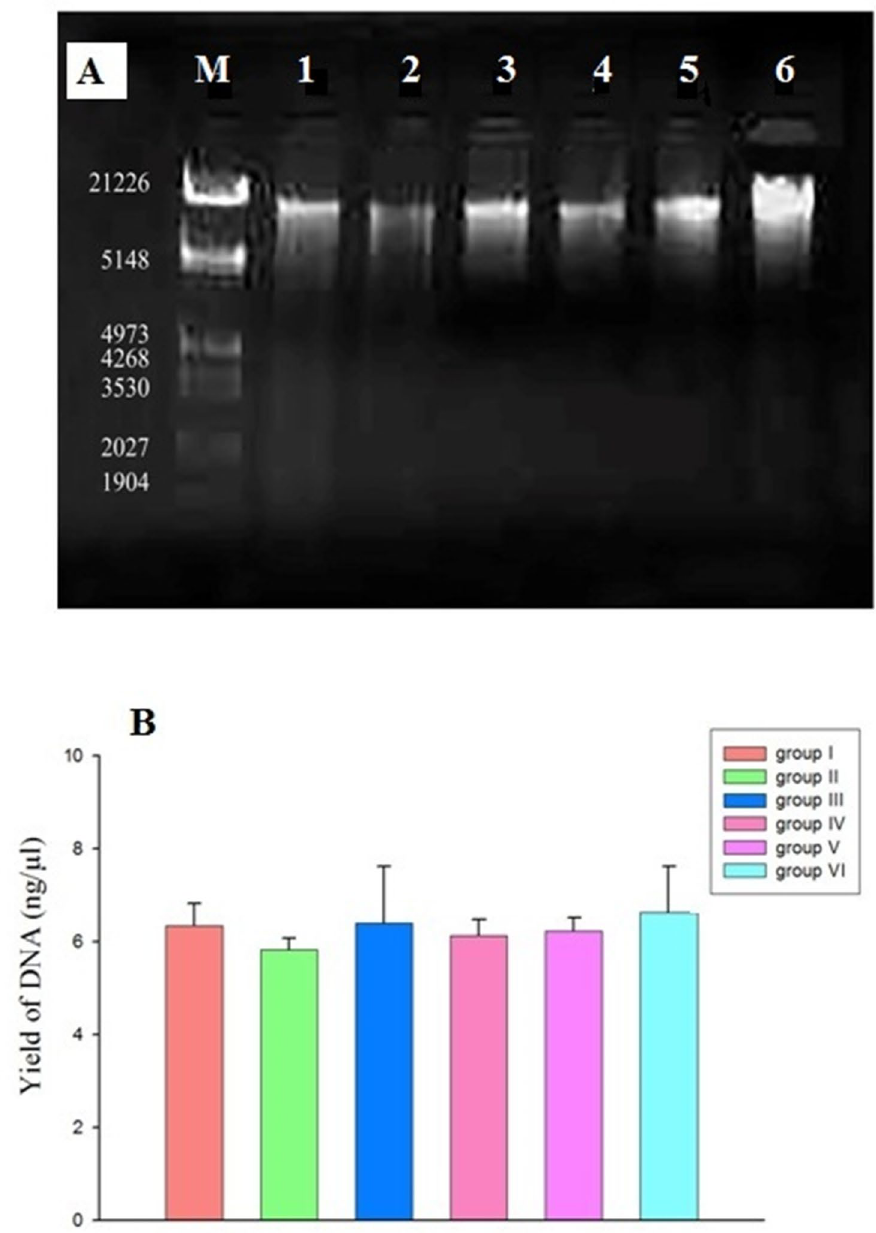
Figure 3. A,B Isolated DNA and their yield from the brains of differently treated mice. M—marker, Lane 1— group I, Lane 2—group II, Lane 3—group III, Lane 4—group IV, Lane 5—group V, Lane 6—group